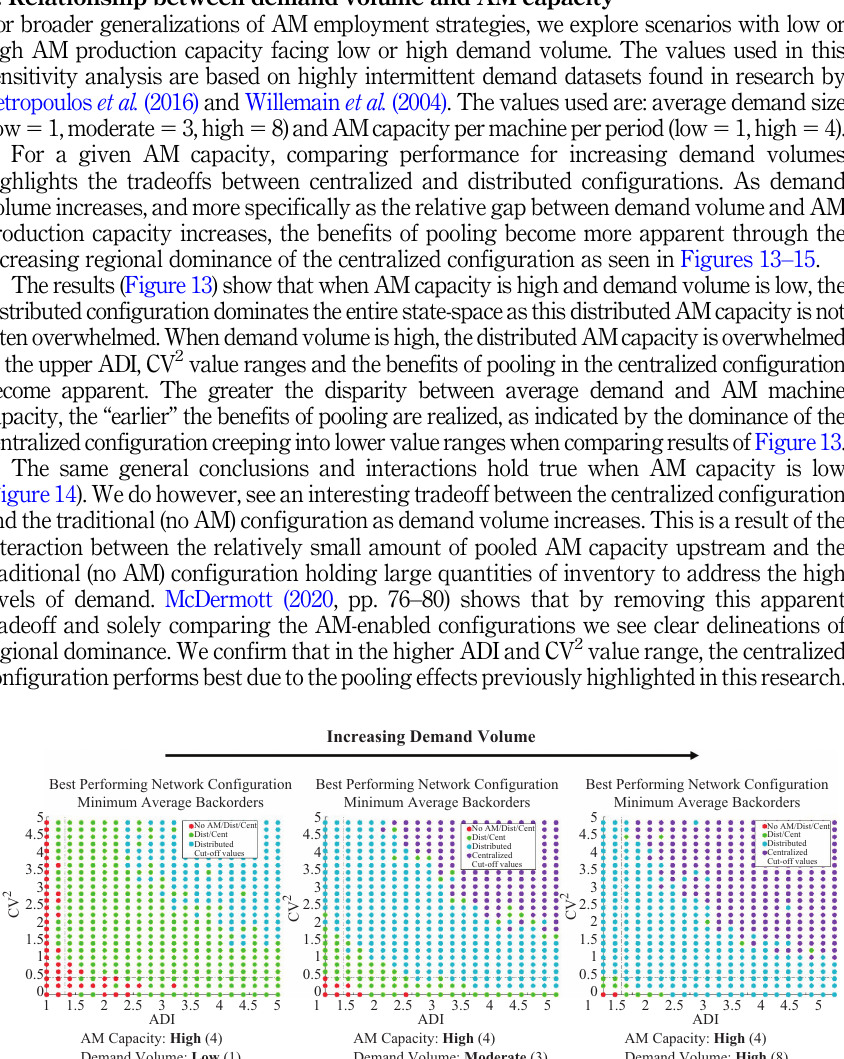
Figure 13. (Color online) Comparisonofnetwork configuration performance for a fixed AM machine capacity of 4 parts per period and increasing demand